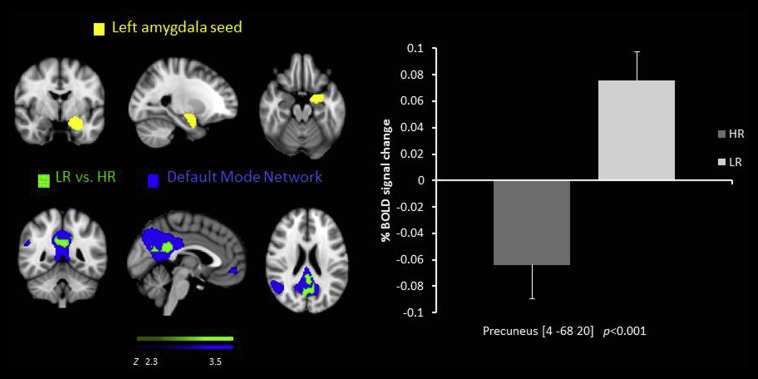
Resting state functional connectivity between the left amygdala seed region  and the precuneus, lower in the HR group than the LR  overlaid on the DMN . % BOLD signal change extracted for connectivity for both of the groups.